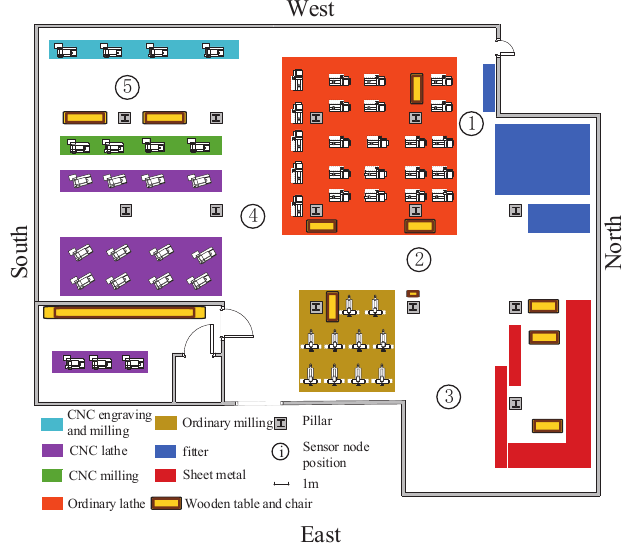
Figure 8. The network